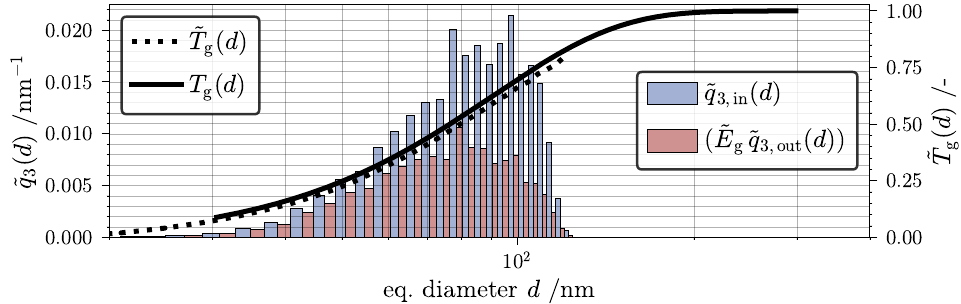
Figure 11. Volume weighted density distribution of virtual particle system (VPS) feed- and centrate suspension (left ordinate) and global grade efficiency (right ordinate). Distribution data are acquired by a marginalization of three dimensional (3D) tubular centrifuge model (TCM) output. Dimensional reduction applied for comparison between T g and ˜ T g